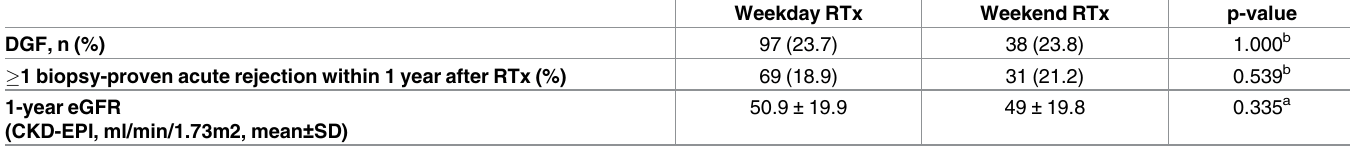
Table 5. Frequencies of DGF, acute rejections within 1 year and 1-yeareGFR.